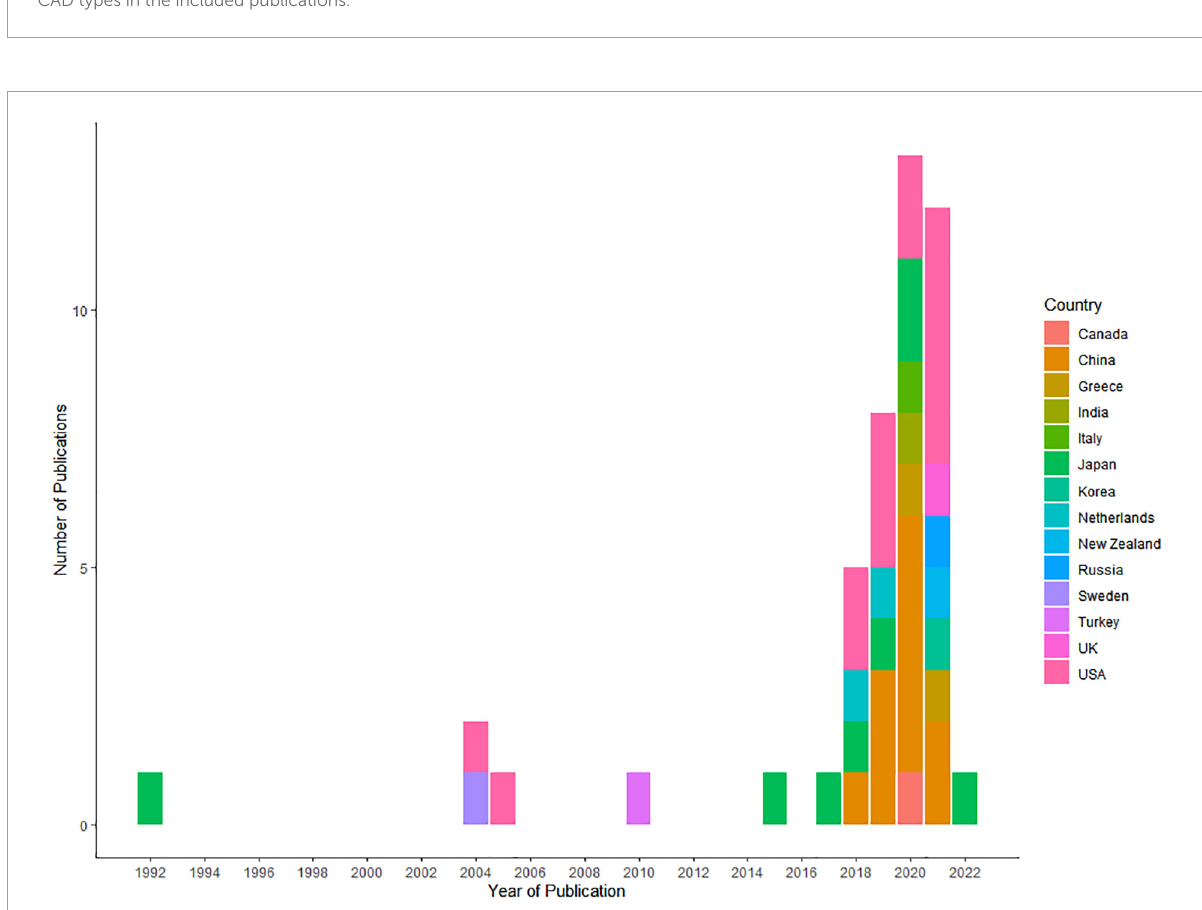
FIGURE2 Number of publications by year and